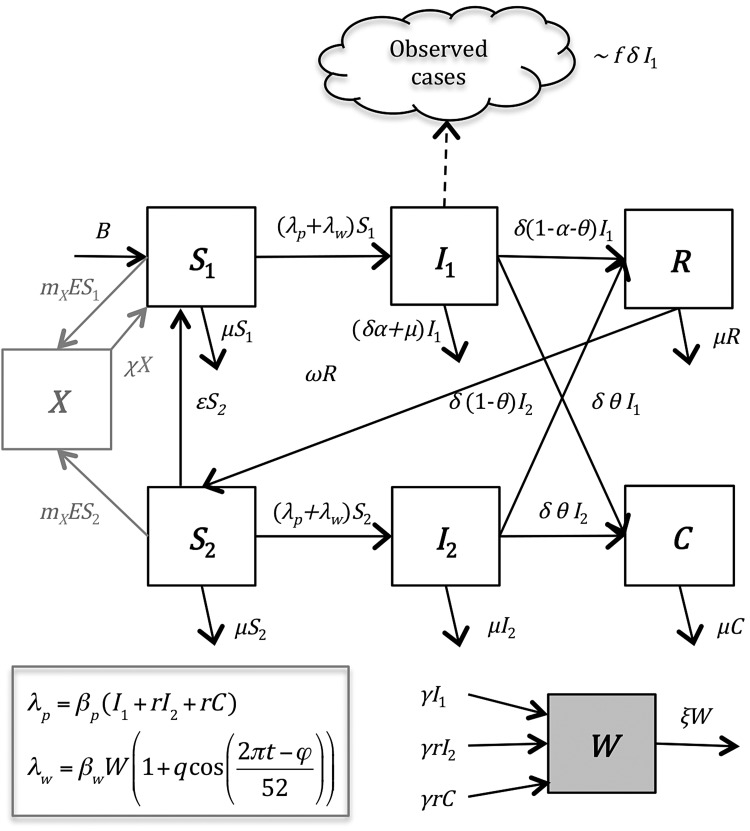
Compartmental diagram of model structure. The model is described in the “Methods” section (“Model Description”).